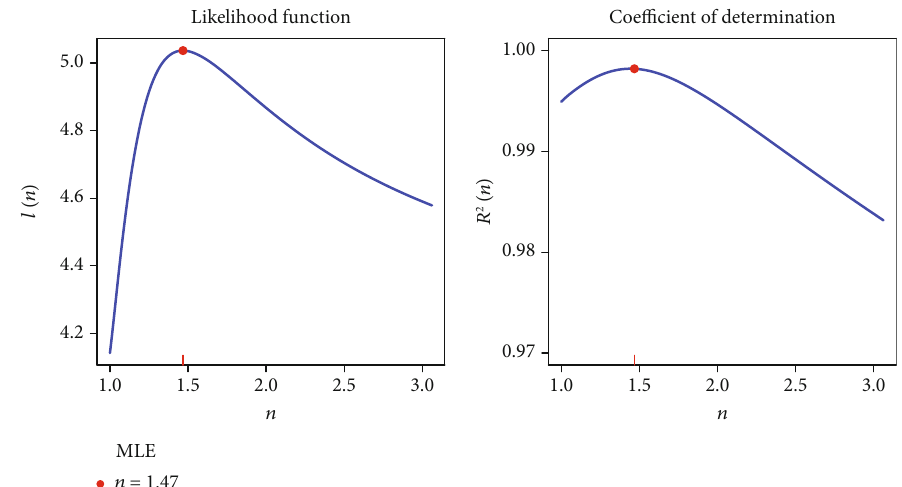
Figure 5: Indicators of the fi t of the TOU model for DR80 adsorption (initial concentration = 20 mg/L) at di ff erent values of n : log-likelihood (left) and coe ffi cient of determination (right).